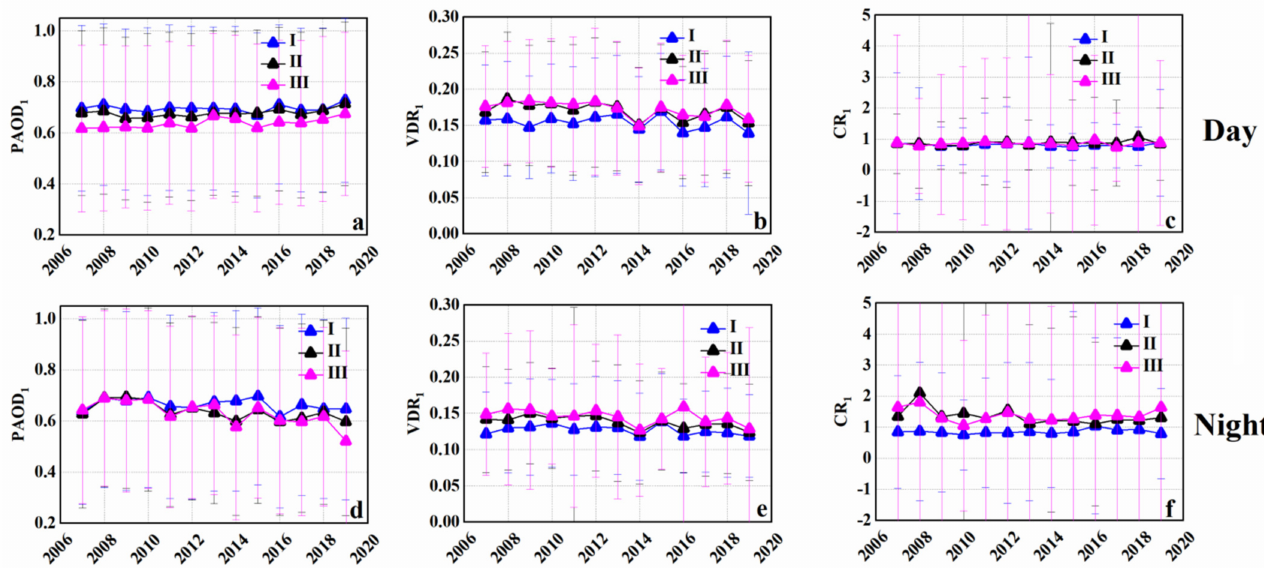
Figure 4. Interannual variations of aerosol layers over Saudi Arabia (region I, region II, and region III) from 2007 to 2019. ( a , d ) the AOD proportion of the lowest aerosol layer (PAOD 1 ), ( b , e ) the volume depolarization ratio of the lowest aerosol layer (VDR 1 ), and ( c , f ) the color ratio of the lowest aerosol layer (CR 1